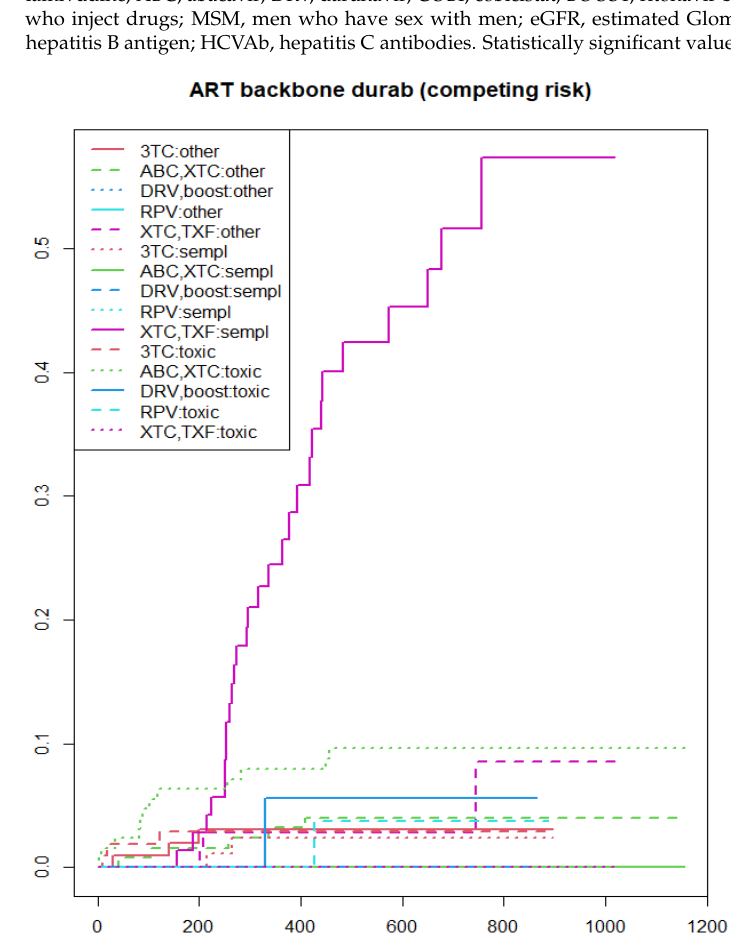
Figure 5. Kaplan–Meier survival curve, obtained by a competing risk analysis, shows how the tenofovir-containing backbone was mainly interrupted due to simplification strategies. DURAB, durability; SEMPL, simplification; ART, antiretroviral treatment; TOXIC, toxicity; RPV, rilpivirine; TXF, tenofovir alafenamide or tenofovir disoproxil fumarate; XTC, emtricitabine or lamivudine; 3TC, lamivudine; ABC, abacavir; DRV, darunavir; Boost, ritonavir-boosted regimens. X -axis: time (days); Y -axis: survival rate (%). Table 3. Hazards of treatment interruption in relation to each of the outcome events (multivariable analysis). Hazards of Interruption (95% Confidence Interval; p -Value) Due